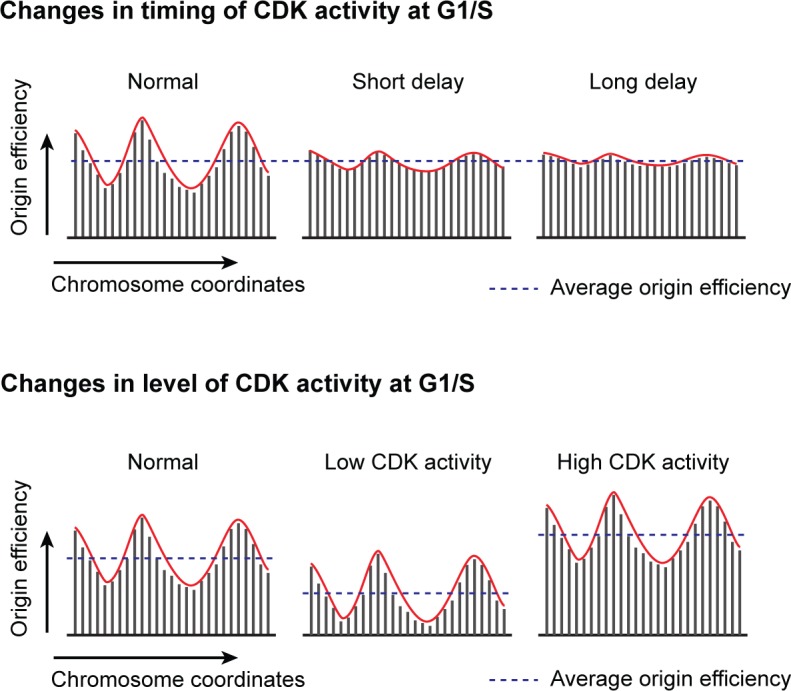
Diagram illustrating the regulation of the replication program through modulation of CDK activity.Dashed lines: average efficiencies of all of the origins in each program; red lines: regional efficiency profiles of origin usage. Top panel: Changes in the timing at which CDK activity reaches the S phase threshold result in reprogramming of replication efficiency domains. Our results show that a major equalization of origin efficiencies occurs as a consequence of short G1 extensions, while a prolonged delay leads to a minor further alteration of the replication pattern. Bottom panel: Alterations in the level of CDK activity at the G1/S transition generate quantitative changes in origin efficiencies across the entire genome without affecting the domains of efficiencies. In this case, average origin efficiencies vary depending on activity levels.